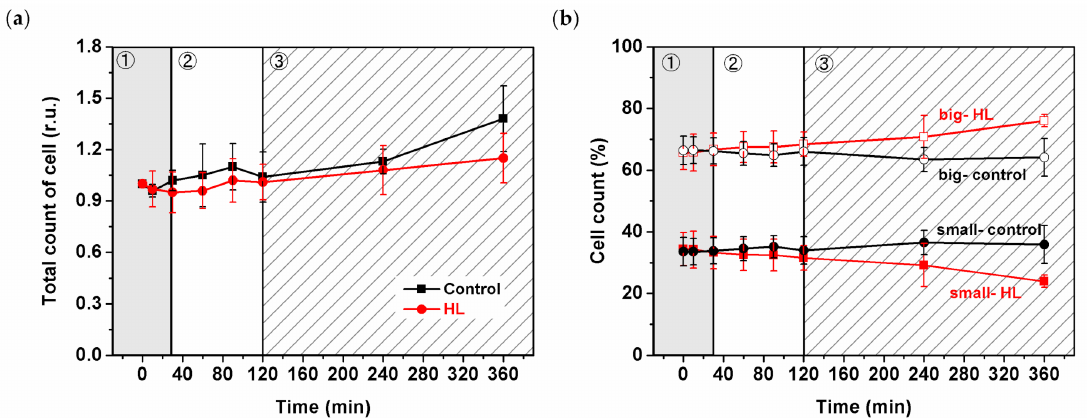
Figure 1. Changes in the number of Synechocystis PSI - YFP cells measured by cell counter during high-light (HL) treatment. ( a ) Relative changes in total cell count obtained independently of cell sizes. Data are normalized to time 0 min. ( b ) Relative changes in cell count of small (diameter ≤ 1.85 µ m) and big (diameter > 1.85 µ m) cells. Black lines = control; Red lines = HL treatment. The three phases of cyanobacterial cell response to HL (see Konert et al. 2019 [5]) are marked by different background colors and numbers (grey—fast response; white—intermediate phase; striped—acclimation phase). Data represent averages and SD from three biological replicates, the starting culture (t = 0 min) typically contains n = 10 6 cells per